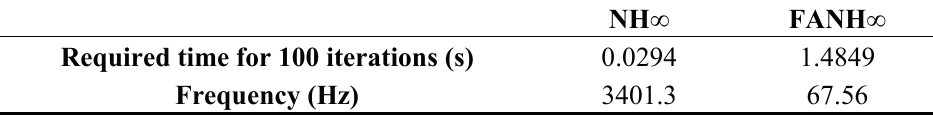
Table 2. Comparison of the computation time between the NH ∞ and FANH ∞ filters.